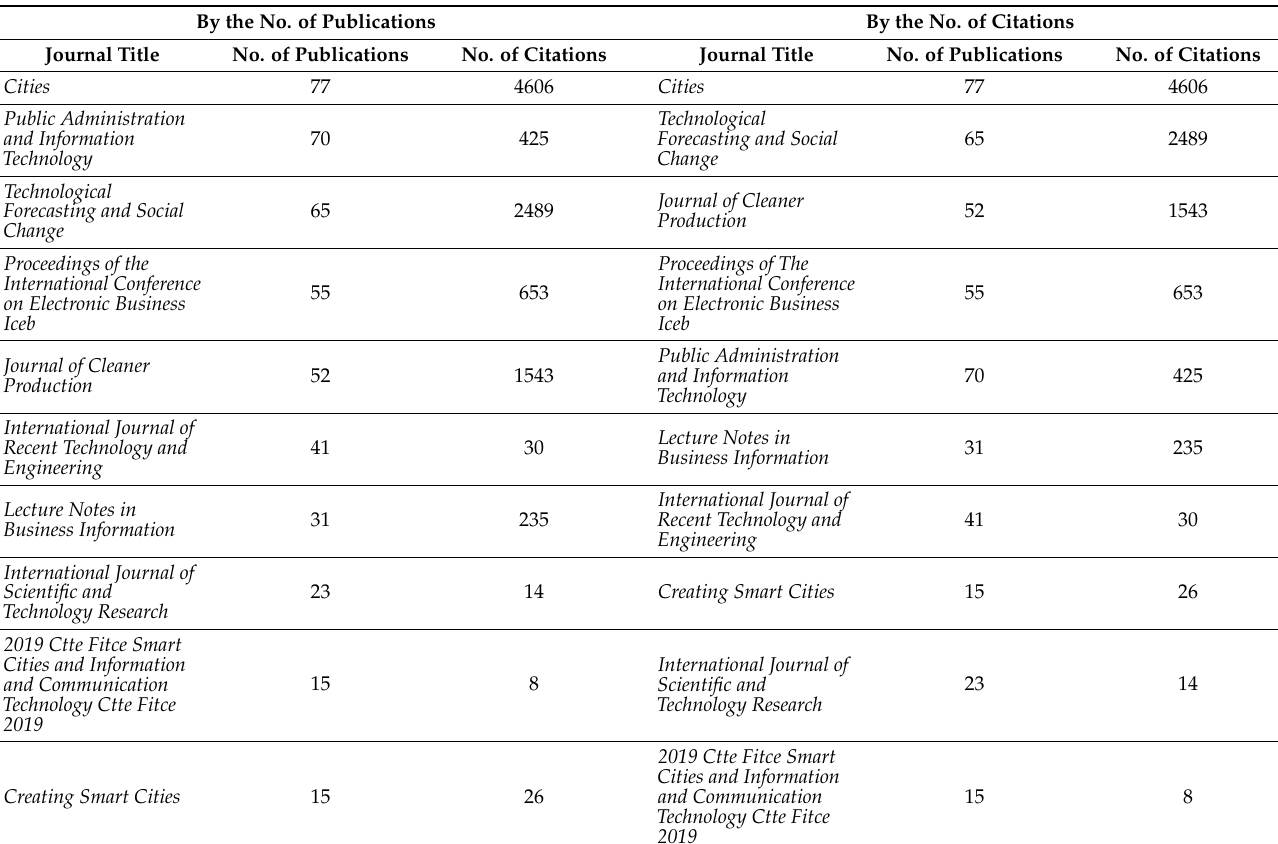
Table 4. Journals with the highest number of